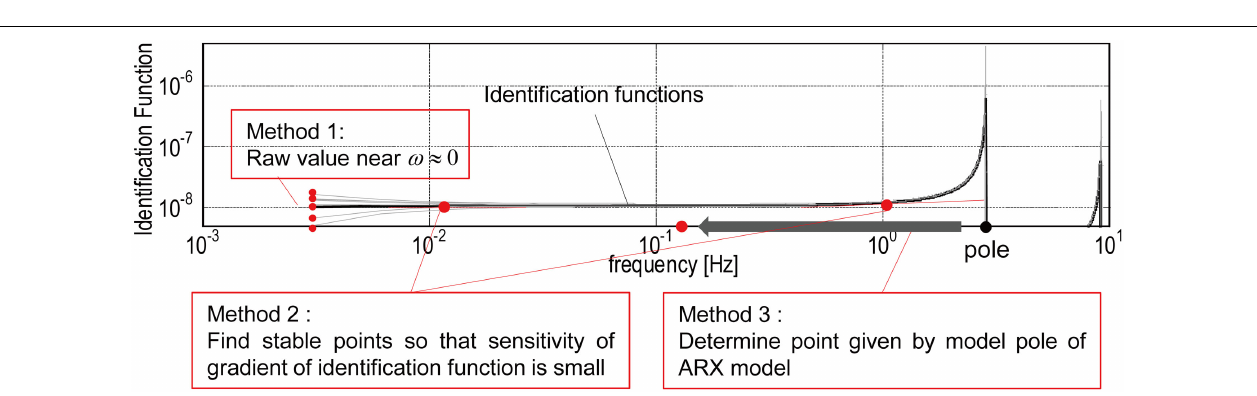
FIGURE 12 | Limit value evaluation for identification functions derived by ARX model .